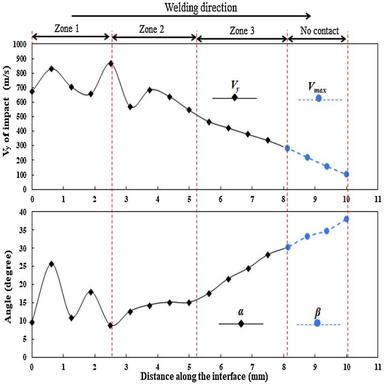
shows the cross section of the MPW weld, revealing various interface morphologies along the welding direction (from right to left) corresponding to various impact conditions. They include (1) unwelded zone at the onset of the weld (Fig. 6b); (2) formation of vortices + IM layers along the interface (Fig. 6c–e); and (3) various wave morphologies (with different amplitudes and wavelengths) (Fig. 6f–i). At the onset of welding, the impact conditions correspond to Zone 1 in, the higher